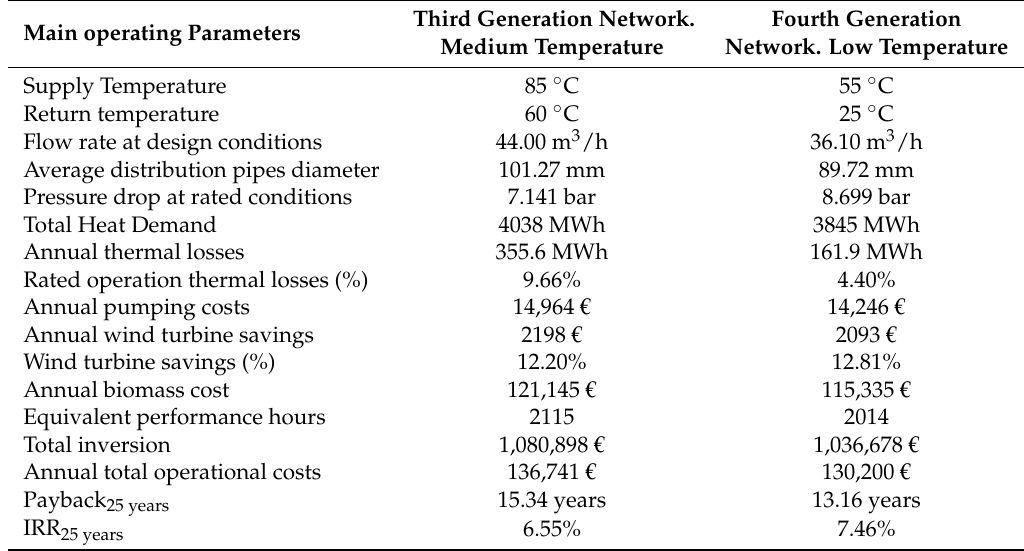
Table 2. Main operating parameters for both DH